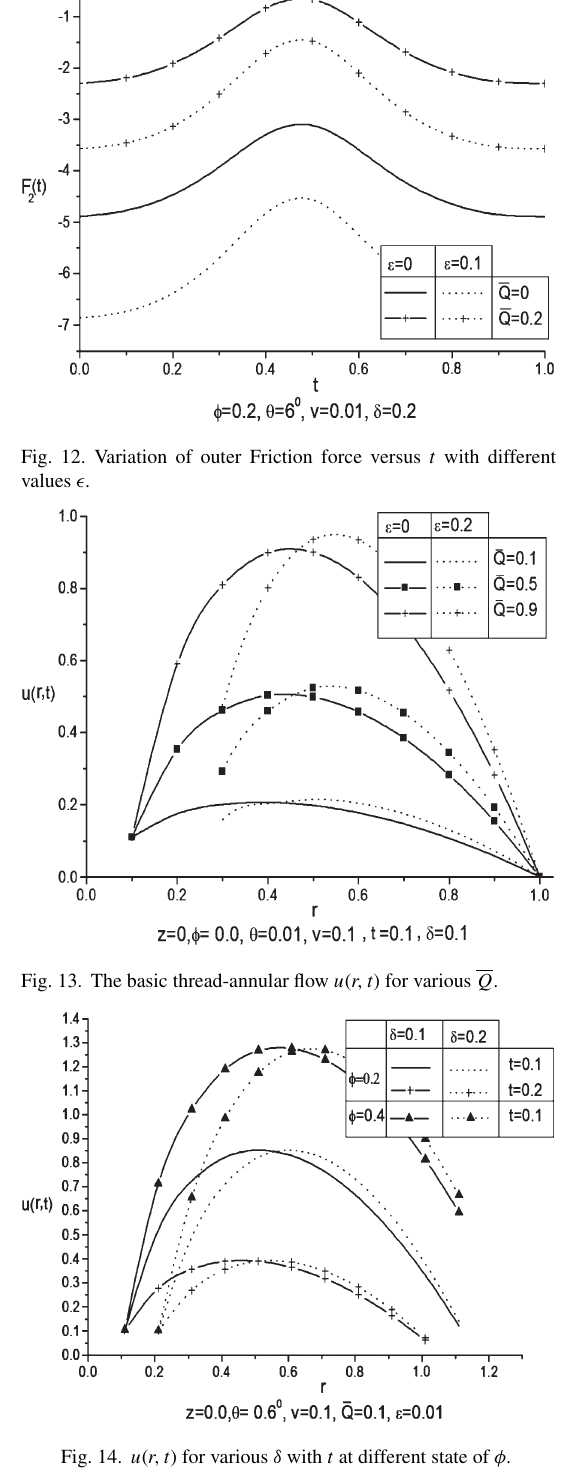
Fig. 14. u ( r,t ) for various δ with t at different state of φ .